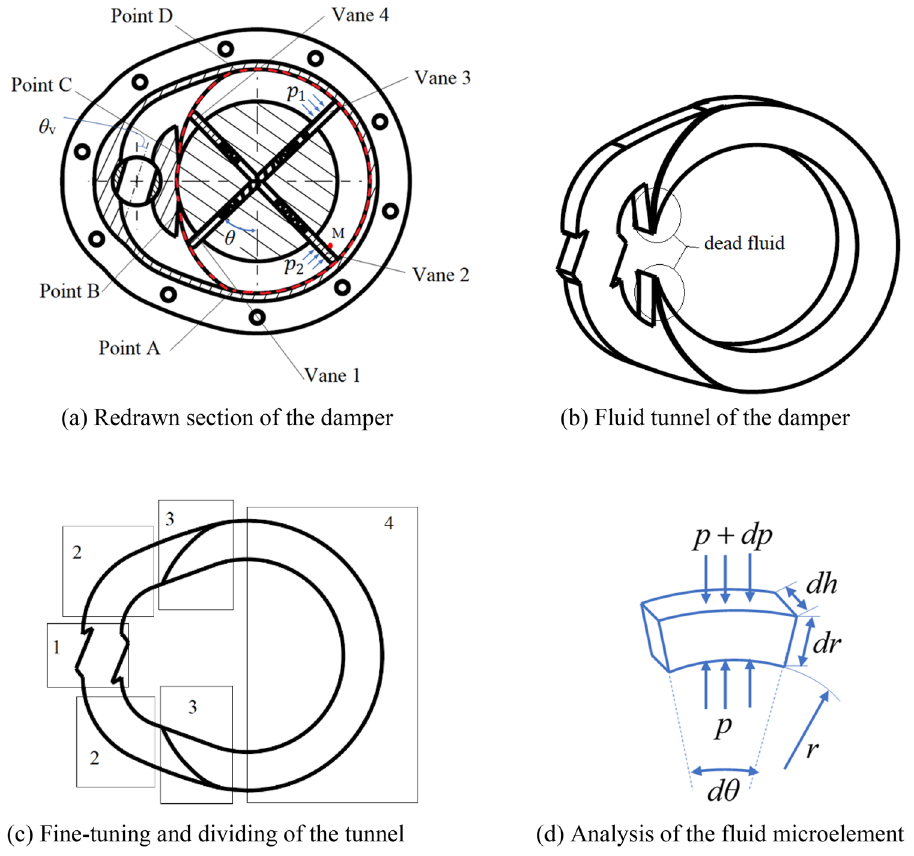
Figure 2. Fluid tunnel and microelement analysis of the damper. (Figures ( a )–( c ) are drawn with the software Creo/parametric, trial version. Figure ( d ) is drawn with the drawing tools of the Microsoft Word software and saved as a